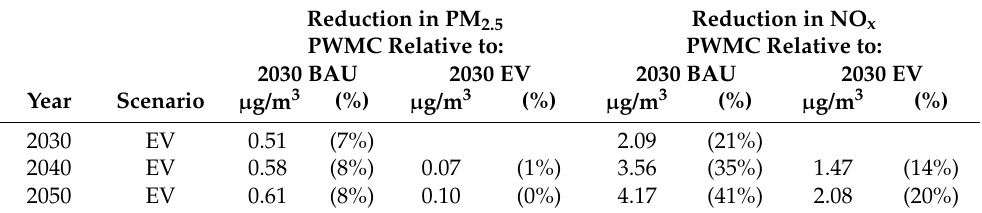
Table 3. Reductions of population weighted mean concentration (PWMC) for PM 2.5 and NO x for the EV scenario from 2030 to 2050, for the whole of the UK; the reduction in PWMC is relative to (i) 2030 BAU scenario and (ii) 2030 EV; values in brackets represent the change as a percentage. Reduction in PM 2.5 PWMC Relative